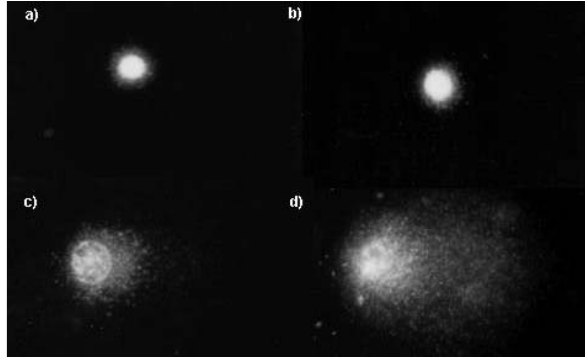
Figure 1 - Comets of Corbicula fluminea (a) class 0 (b) class 1 hemocytes fromhemolymph.CometsofChinesehamsterK1(CHO-K1)cellsc)class 2, d) class 3.